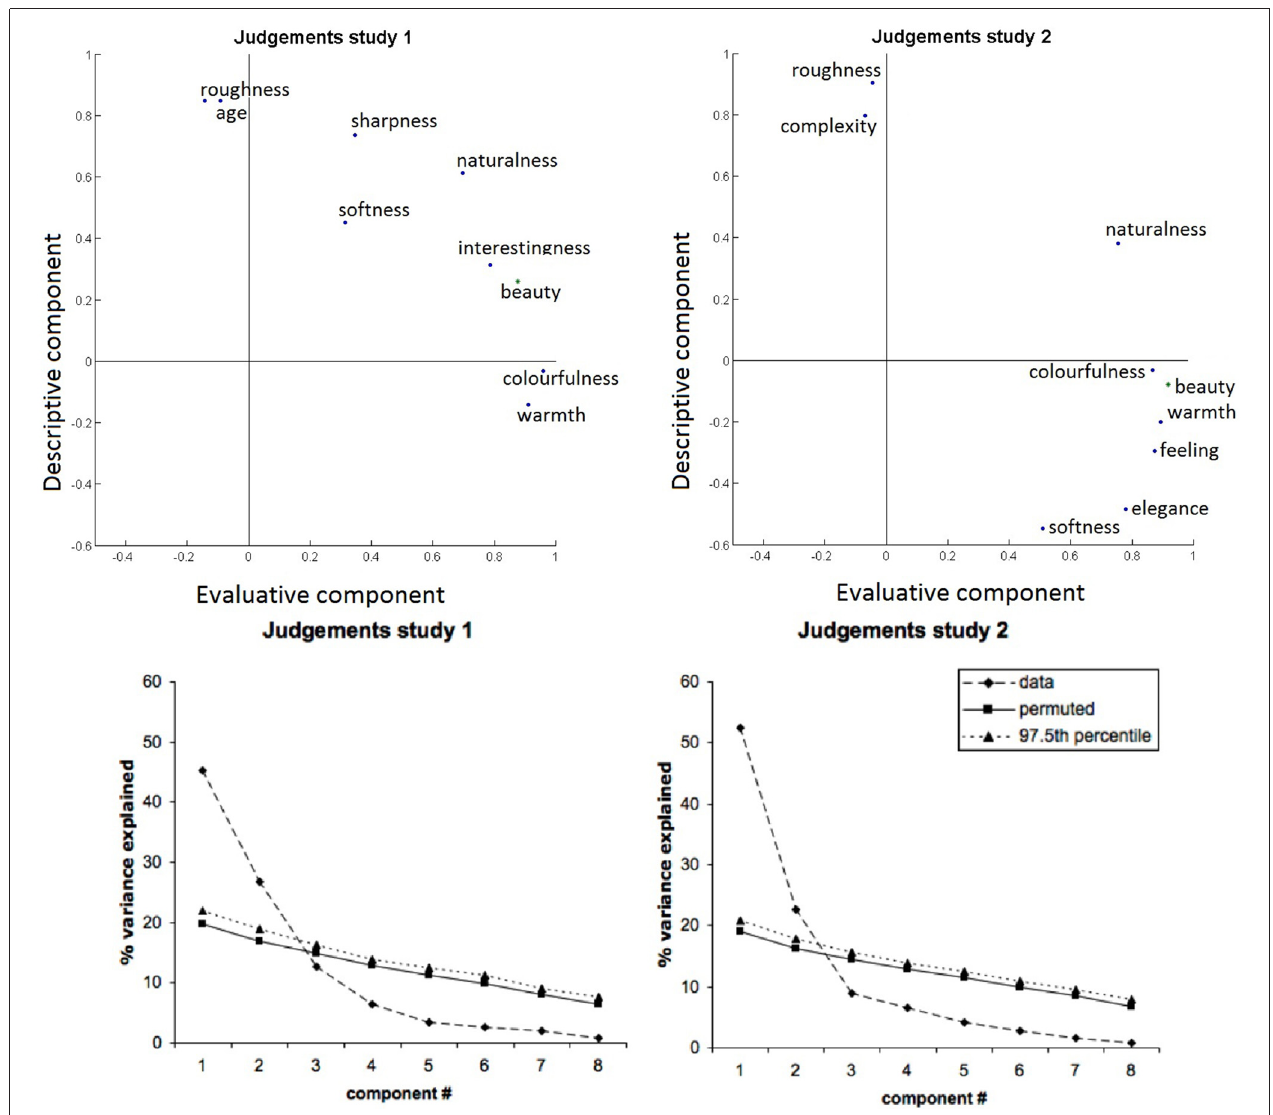
FIGURE 3 | Judgments loadings on the varimax rotated factors, for both studies. Two factors were retained. Most judgments load selectively on one of both factors. Results for the first experiment (left panel) and second experiment (right panel) are very